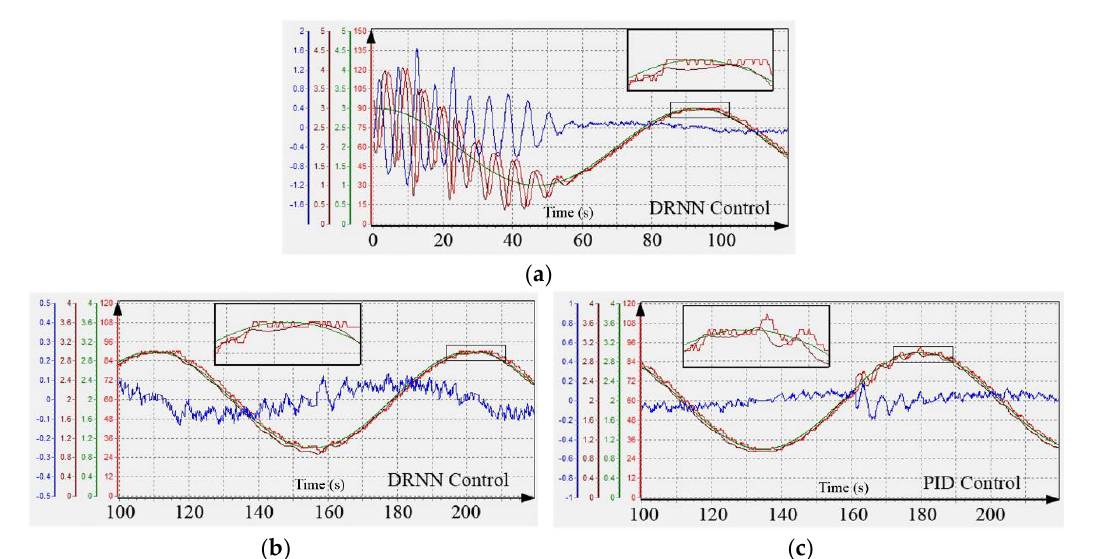
Table 1. Error variance comparison between PI and neural controllers during the steady state